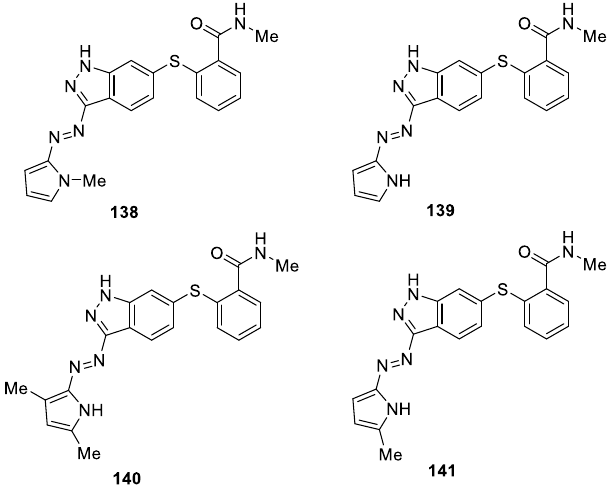
Figure 36. Chemical structures of 1 H -indazole derivatives 138 – 141 .